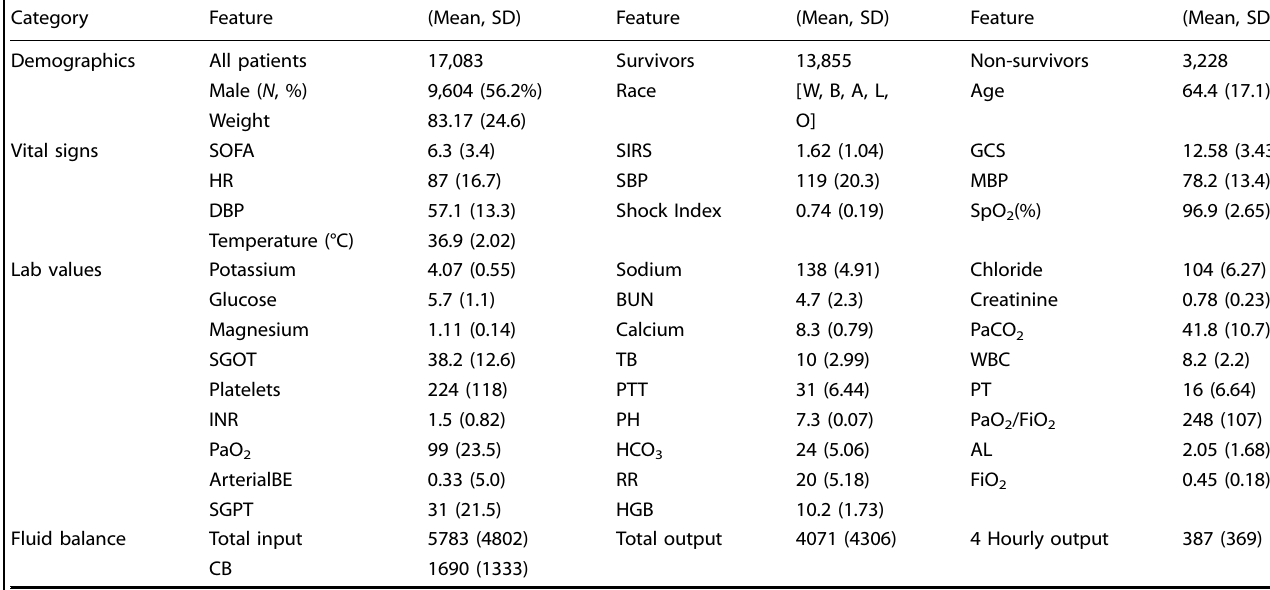
Table 4. Demographics of sepsis cohort. Category